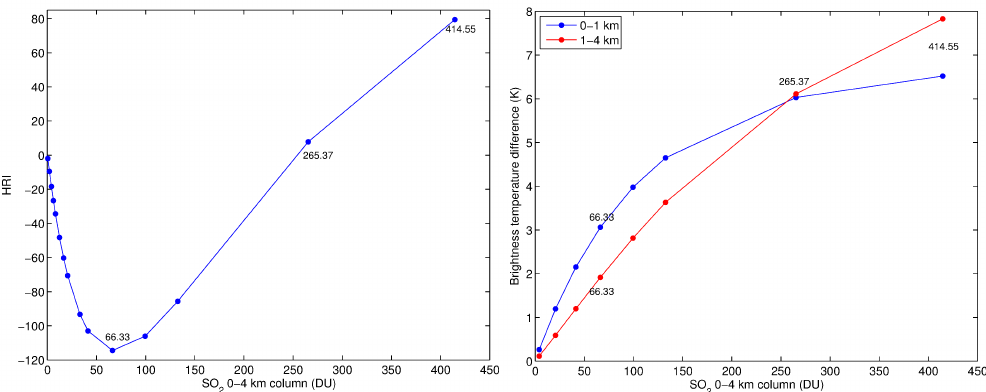
Figure 3. Left panel: evolution of the HRI as a function of the 0–4km column of SO 2 , in the case of negative thermal contrast ( − 10K). In this simulation, the total H 2 O column is 2.4 × 10 20 moleculescm − 2 and the angle bin is 15–20 ◦ . Right panel: contributions of the emission in the 0–1km layer (blue) and of absorption in the 1–4km layer (red) to the IASI spectrum at 1355cm − 1 , expressed in brightness temperature difference (absolute value). Details are given in the